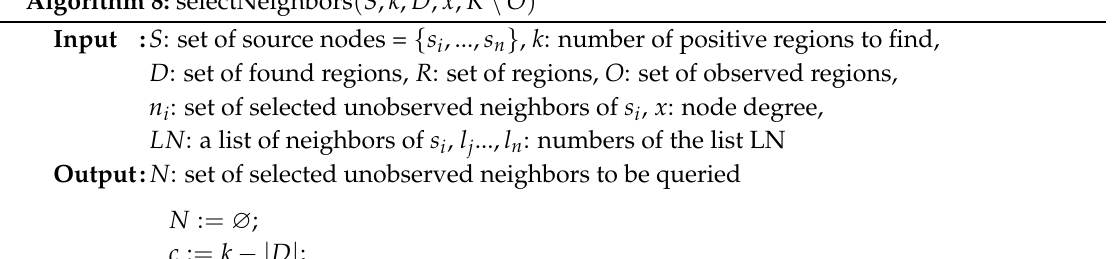
Algorithm 8: selectNeighbors ( S , k , D , x , R \ O